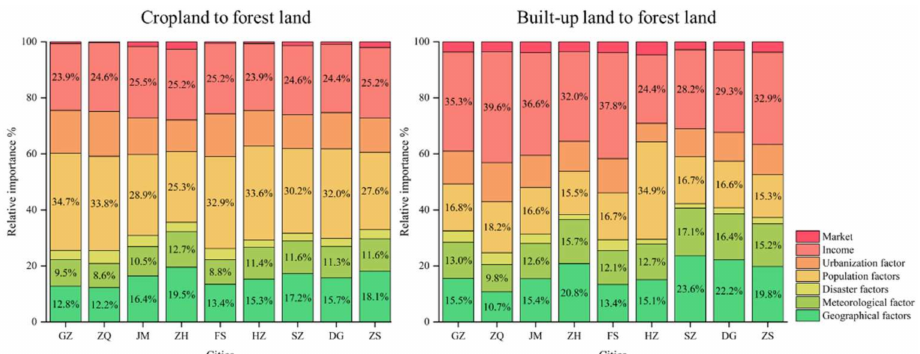
Figure 7. Relative importance of different factors in different cities for afforestation. GZ: Guangzhou; SZ: Shenzhen; ZH: Zhuhai; FS: Foshan; JM: Jiangmen; ZQ: Zhaoqing; DG: Dongguan; ZS: Zhongshan; HZ: